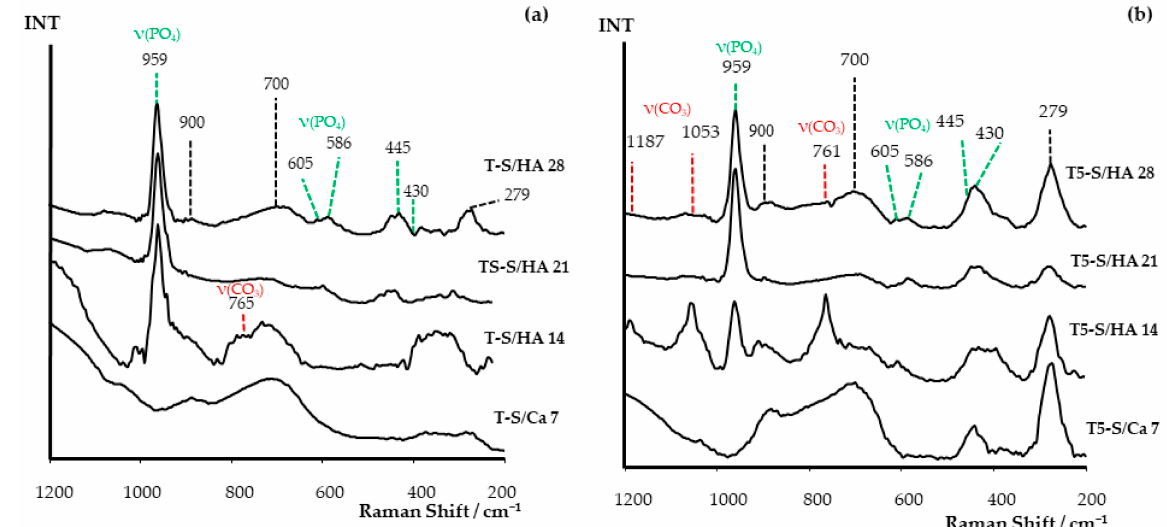
Figure 8. Raman spectra of studied ( a ) T-S/Ca and T-S/HA and ( b ) T5-S/Ca and T5-S/HA after immersion in SBF for 7, 14, 21, and 28 days. The undescribed peaks came from titanate.